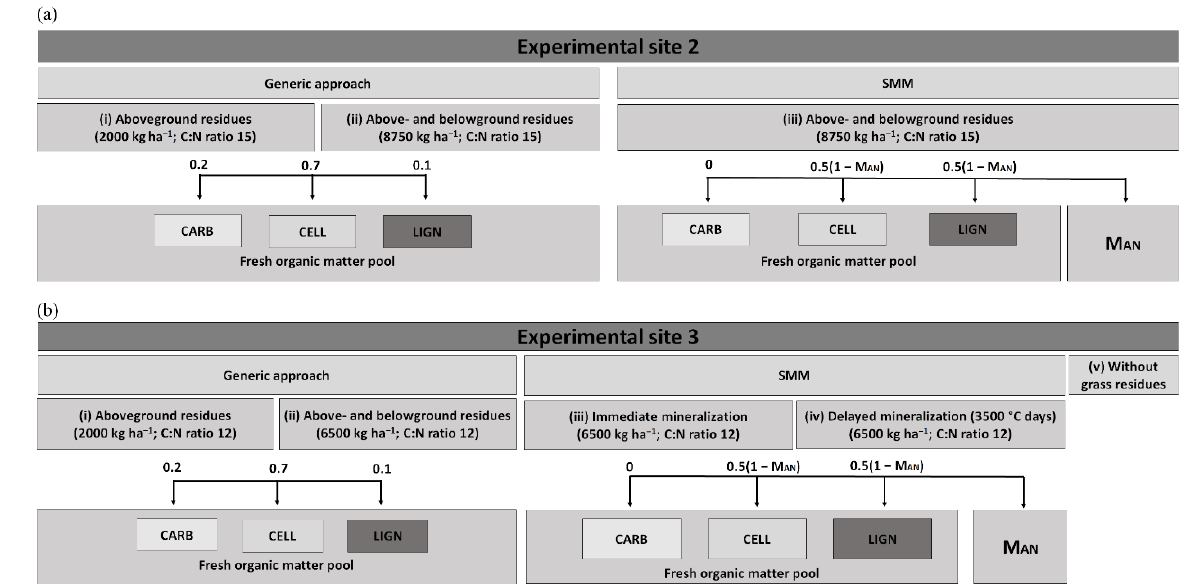
Figure 1. Overview of the modeling approaches for experimental site 2 ( a ) and experimental site 3 ( b ). The numbers show the fraction of C and N in the grass residues partitioned to the three fresh organic matter pools (carbohydrates (CARB), cellulose (CELL), and lignin (LIGN)) during mineralization. In the simple mineralization model (SMM), the mineralization rate is based on soil temperature, soil moisture, and the C:N ratio of residues. The M AN fraction is the maximum fraction of residues released in the first 200 days after ploughing.